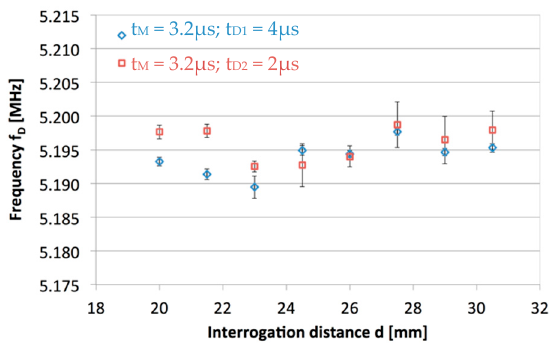
Figure 3. Measured damped frequency f D as a function of the interrogation distance d with t M = 3.2 µs and different delay times t D1 = 4 µs and t D2 = 2